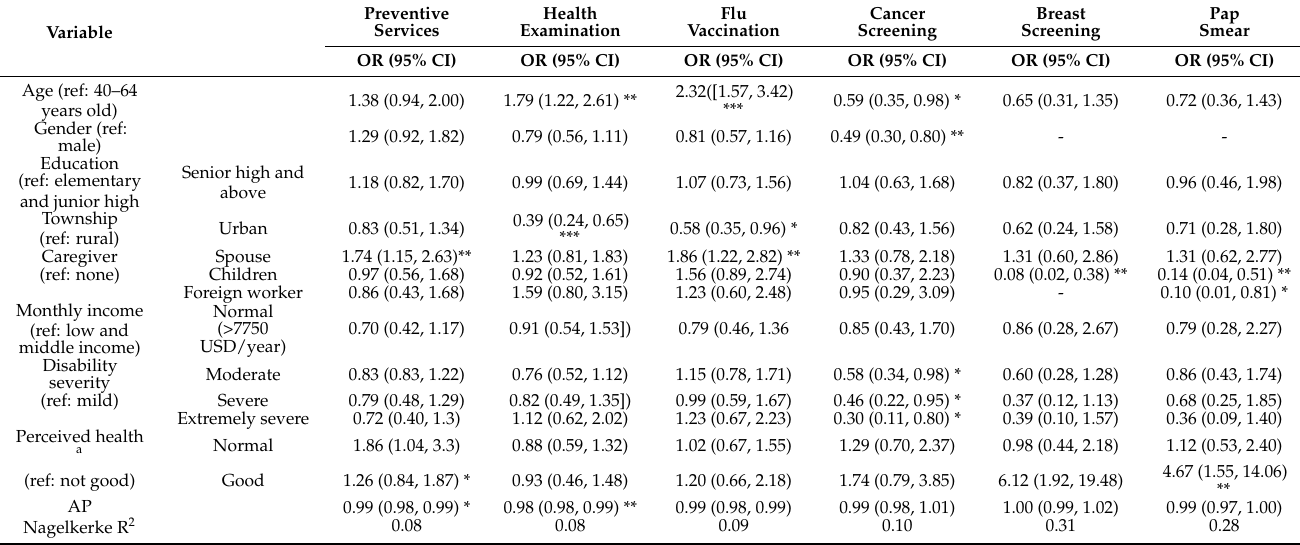
Table 3. Factors associated with the use of preventive health services for people with